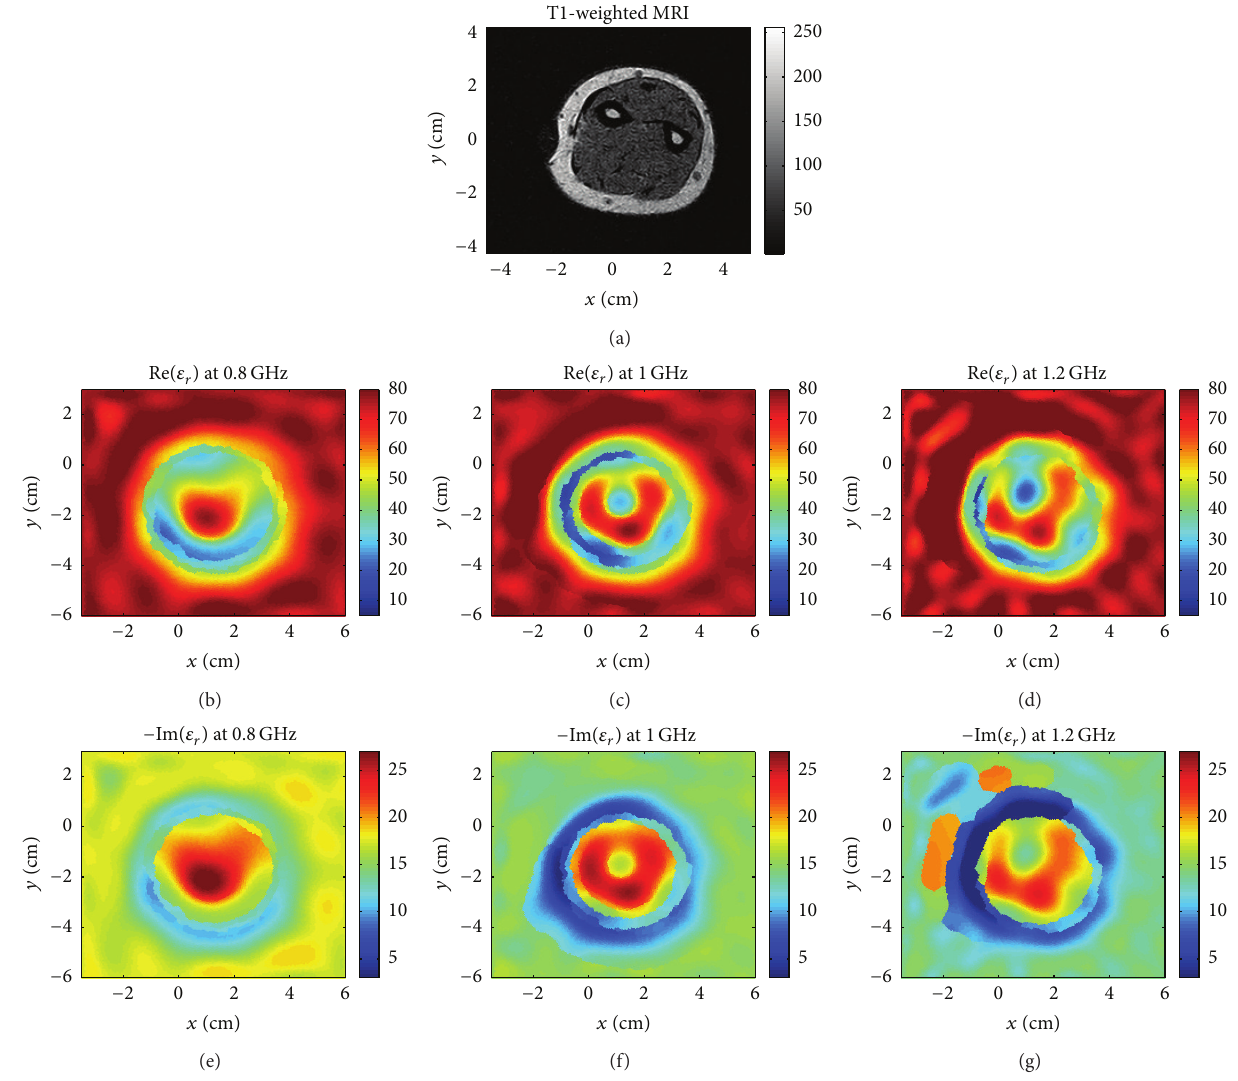
Figure 5: Volunteer 2: (a) the T1-weighted MRI image. MWI reconstructions of the relative complex permittivity real and imaginary compo- nents at (b), (e) 0.8 GHz, (c), (f) 1GHz, and (d), (g)